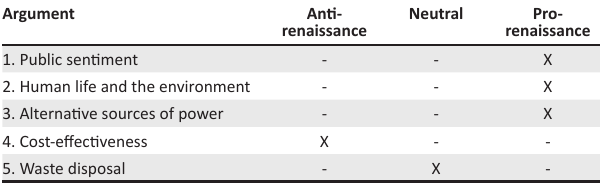
TABLE 3: Summary of nuclear renaissance arguments.